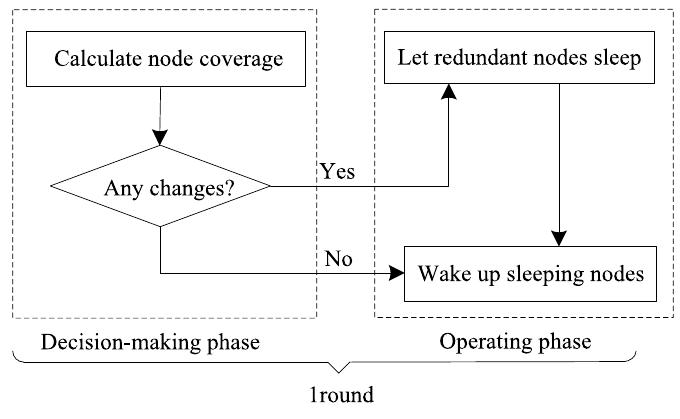
Figure 5. Network reconfiguration mechanism flow